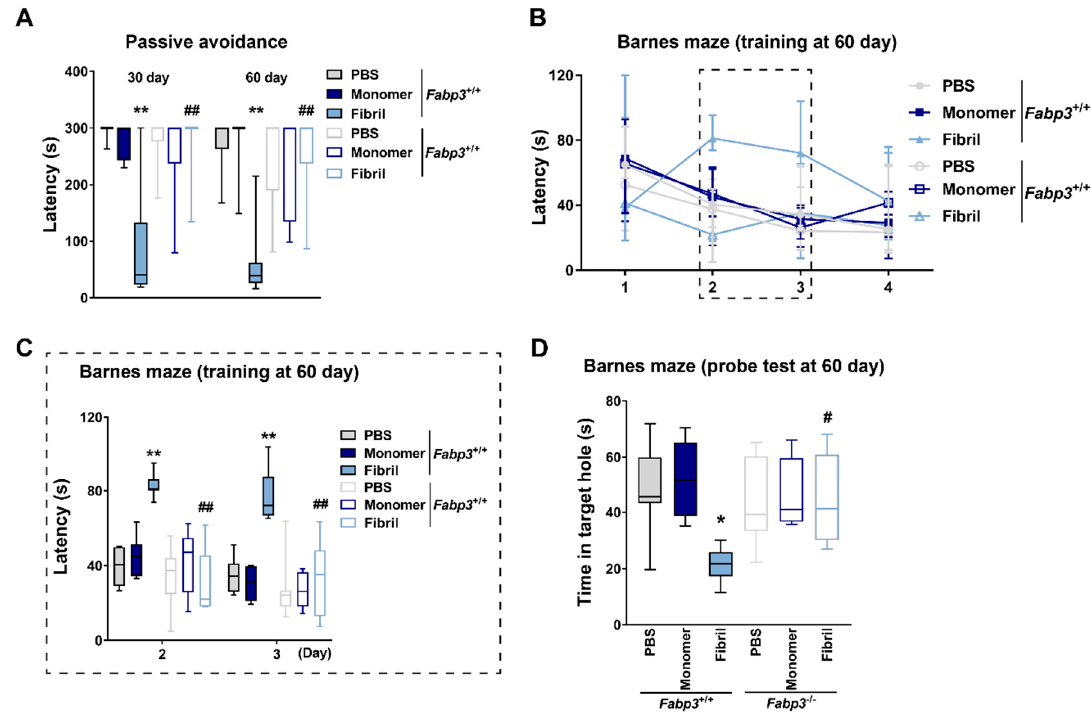
Figure 7. Effects of Fabp3 deletion on cognitive impairments after intrastriatal α Syn injection. ( A ) Latency to enter the dark box in the passive avoidance task ( n = 7 per group). ** p < 0.01 vs. PBS-injected Fabp3 +/+ mice and ## p < 0.01 vs. α Syn fibril-injected Fabp3 +/+ mice in the same day. ( B , C ) Latency to enter the escape box in training sessions in the Barnes maze task ( n = 7 per group). The sessions were conducted twice per day. The insertion ( C ) depicts the days when the latency was significantly different between groups. ** p < 0.01 vs. PBS-injected Fabp3 +/+ mice; ## p < 0.01 vs. α Syn fibril-injected Fabp3 +/+ mice. ( D ) Latency to explore the target hole in the probe test sessions in the Barnes maze task ( n = 7 per group). The test was conducted 7 days after the first training sessions. * p < 0.05 vs. PBS-injected Fabp3 +/+ mice. # p < 0.05 vs. α Syn fibril-injected Fabp3 +/+ mice.